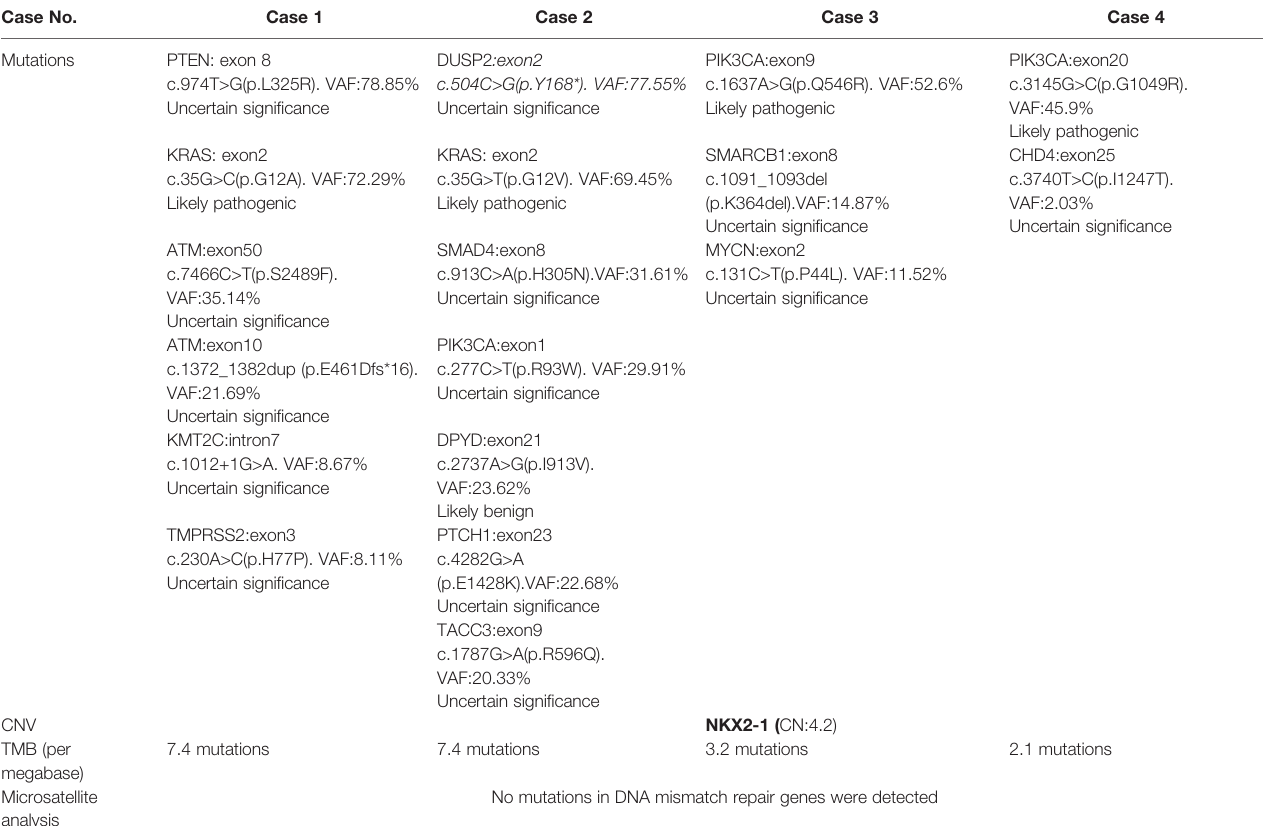
TABLE 4 | Molecular genetic fi ndings of uterine corpus mesonephric-like adenocarcinomas. Case No. Case 1